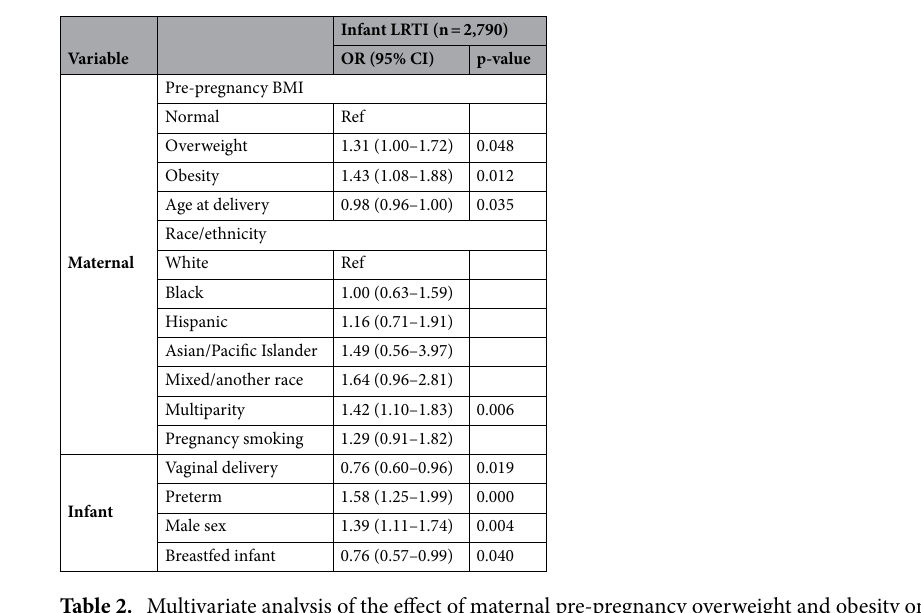
Table 2. Multivariate analysis of the effect of maternal pre-pregnancy overweight and obesity on the odds of lower respiratory tract infections in the first year of life. The analysis was adjusted by age, race/ethnicity, parity, pregnancy smoking, delivery type, gestational age, infant sex, and breastfeeding status. P-values in bold represent statistically significant